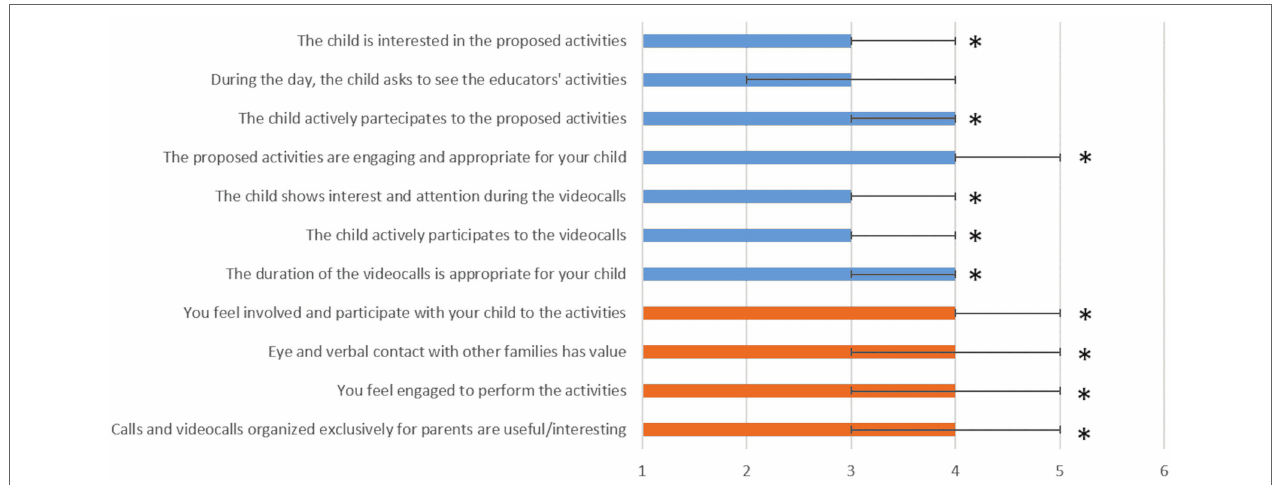
FIGURE 2 | Interests in children (as reported by parents) and parents regarding the proposed activities. Blue bars refer to the children’s involvement, orange bars to the parents. *Chi-square test, p <